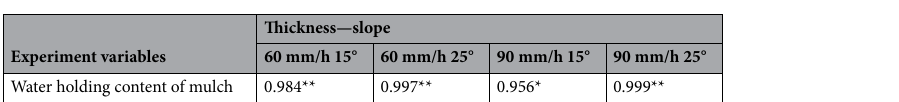
Table 5. Pearson correlation coefficient R between water holding of organic mulch and application of mulch with slope. Two-tail test of significance was used and significant correlations (p < 0.01) are labeled with **, significant correlations (p < 0.05) are labeled with